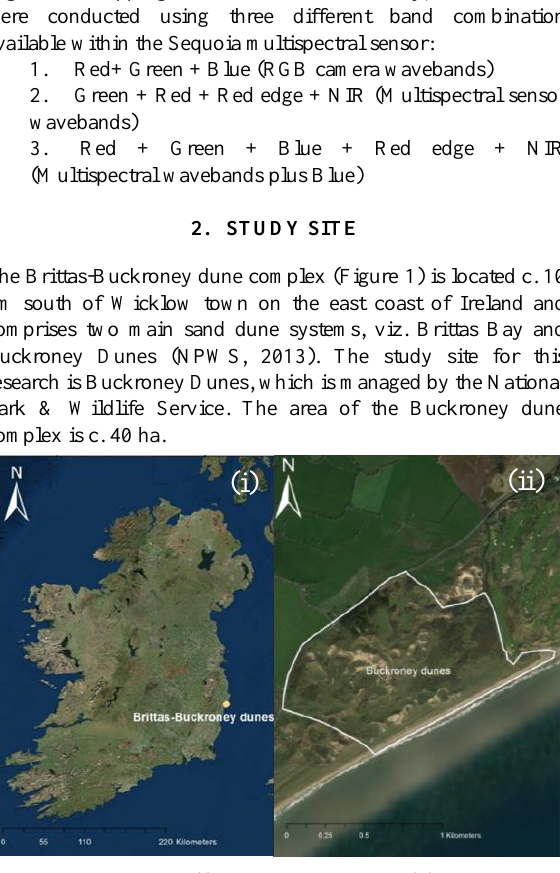
occur at the southern